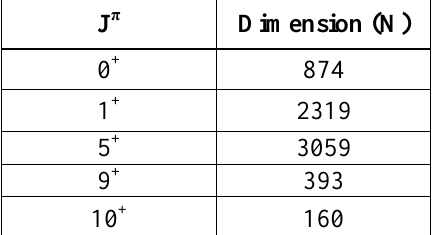
Table 1: Dimensions of all considered J π = ( 0 + ,1 + , 5 + , 9 + , and 10 + ) states for 12 particles in the f5p space.